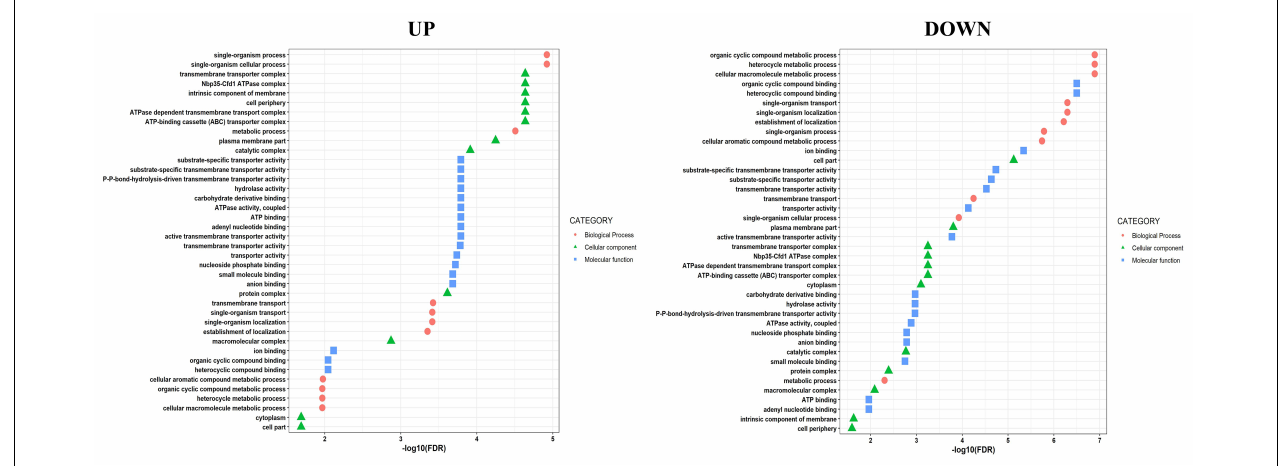
FIGURE 7 | Gene ontology classification in up-regulated and down-regulated genes during PET